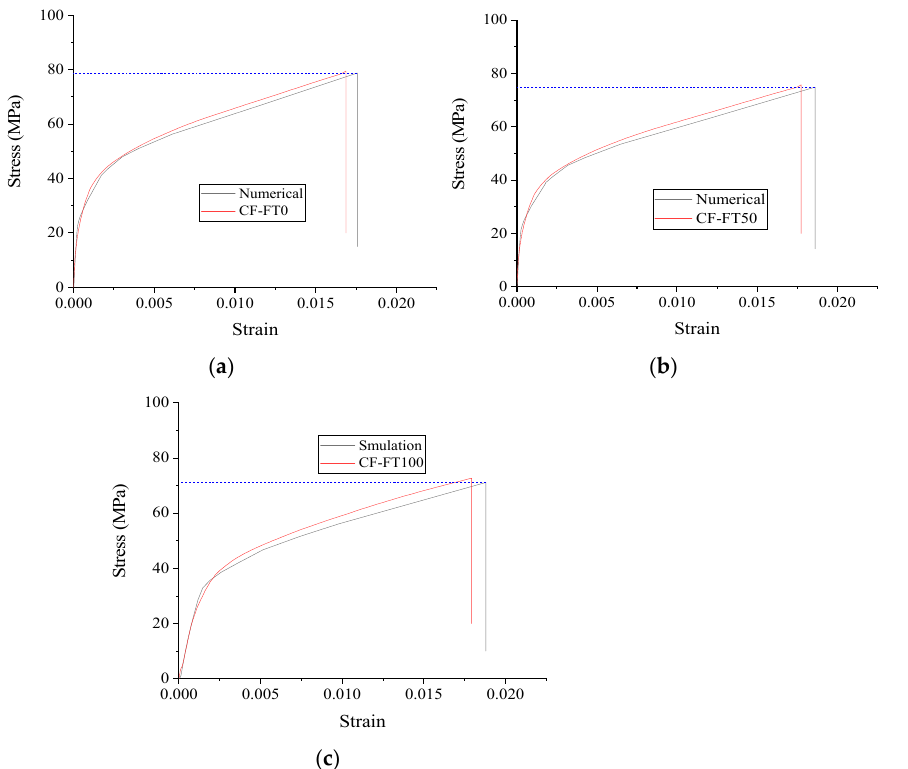
Figure 18. Uniaxial compressive stress–strain relationship for CFRP-reinforced specimens: ( a ) 0